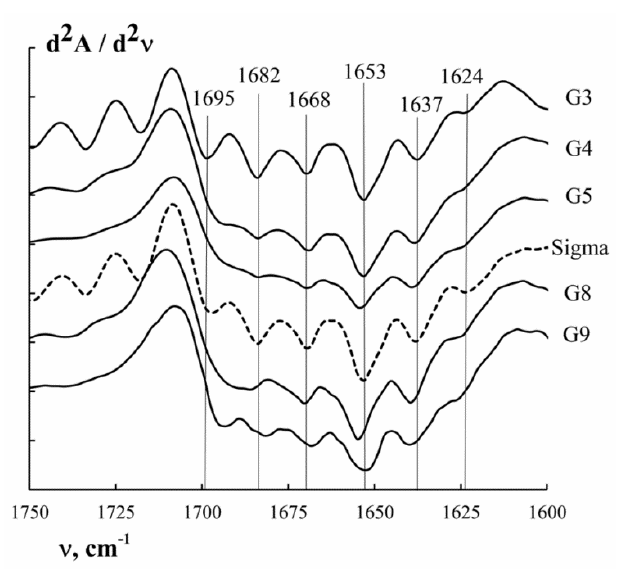
Figure 5. Spectra of the second derivative (differential FTIR spectra) in the absorption region of amide I.